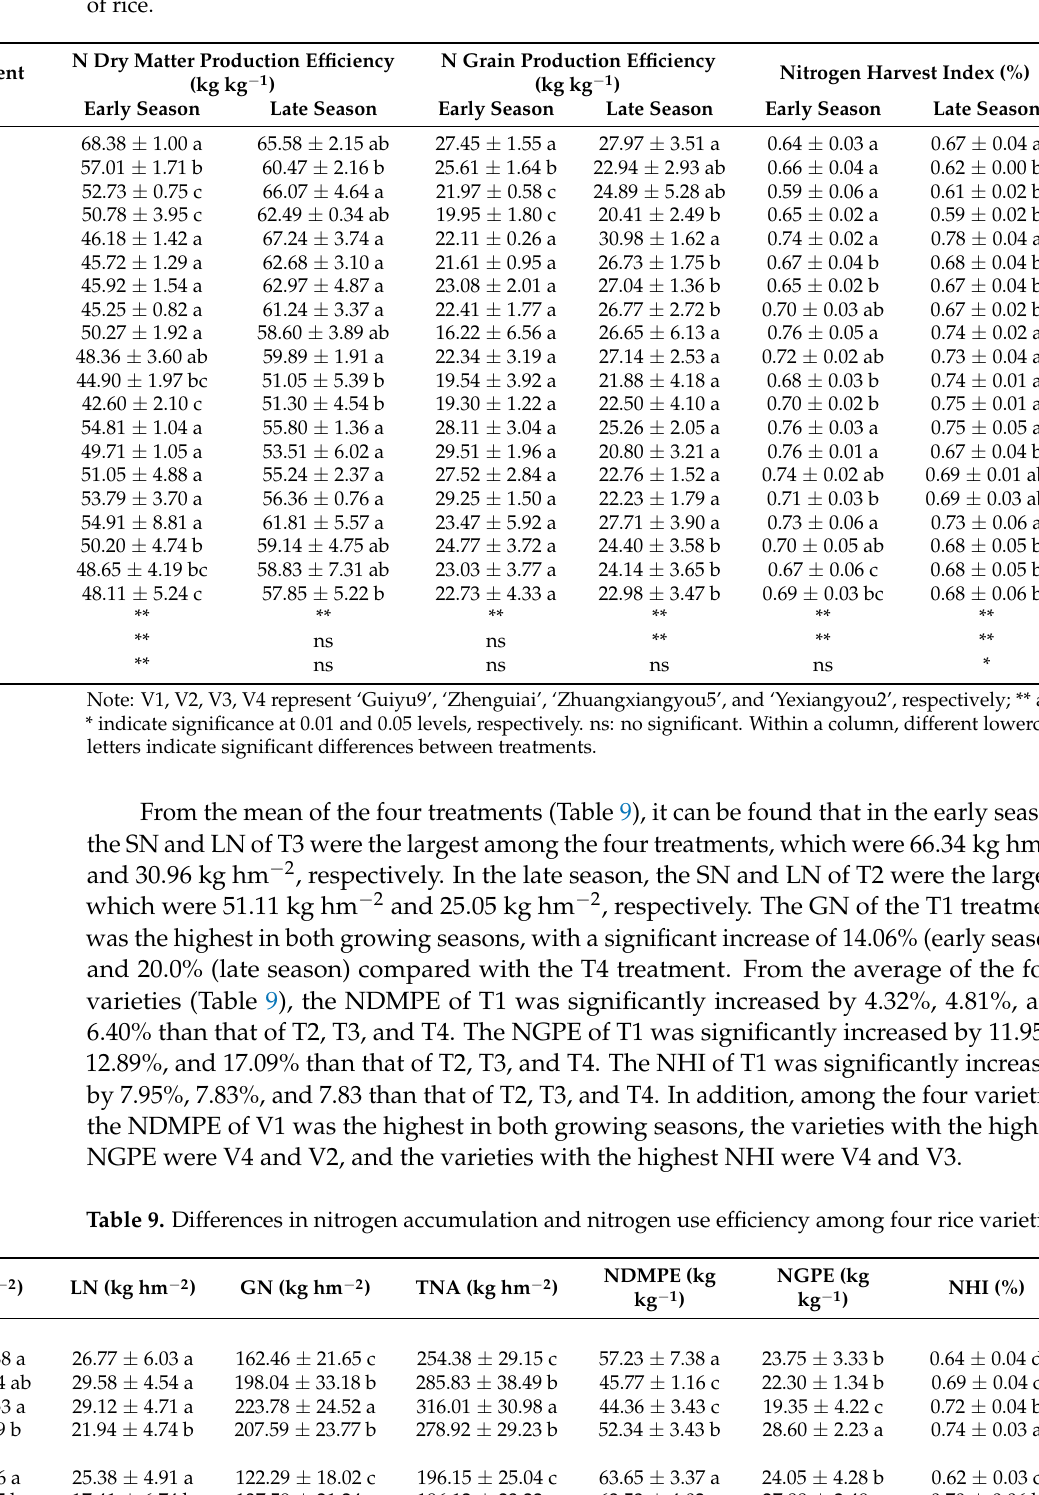
Table 8. Effects of different seedling numbers per hill and row spacing on nitrogen use efficiency of rice.